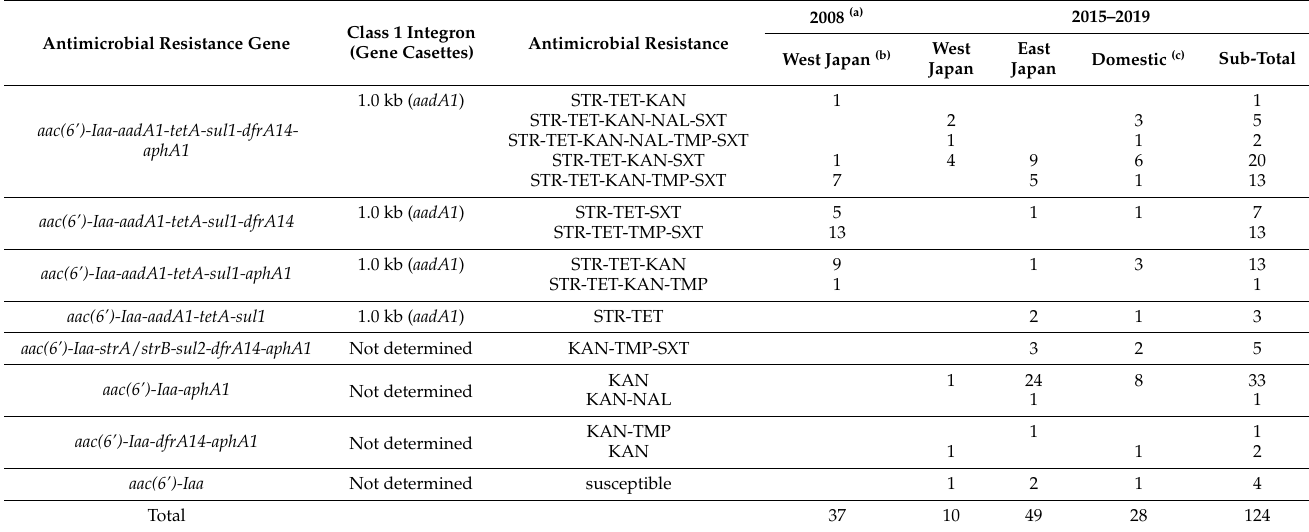
Table 2. Antimicrobial resistance genes present in Salmonella enterica serovar Schwarzengrund isolated from retail chicken meat in